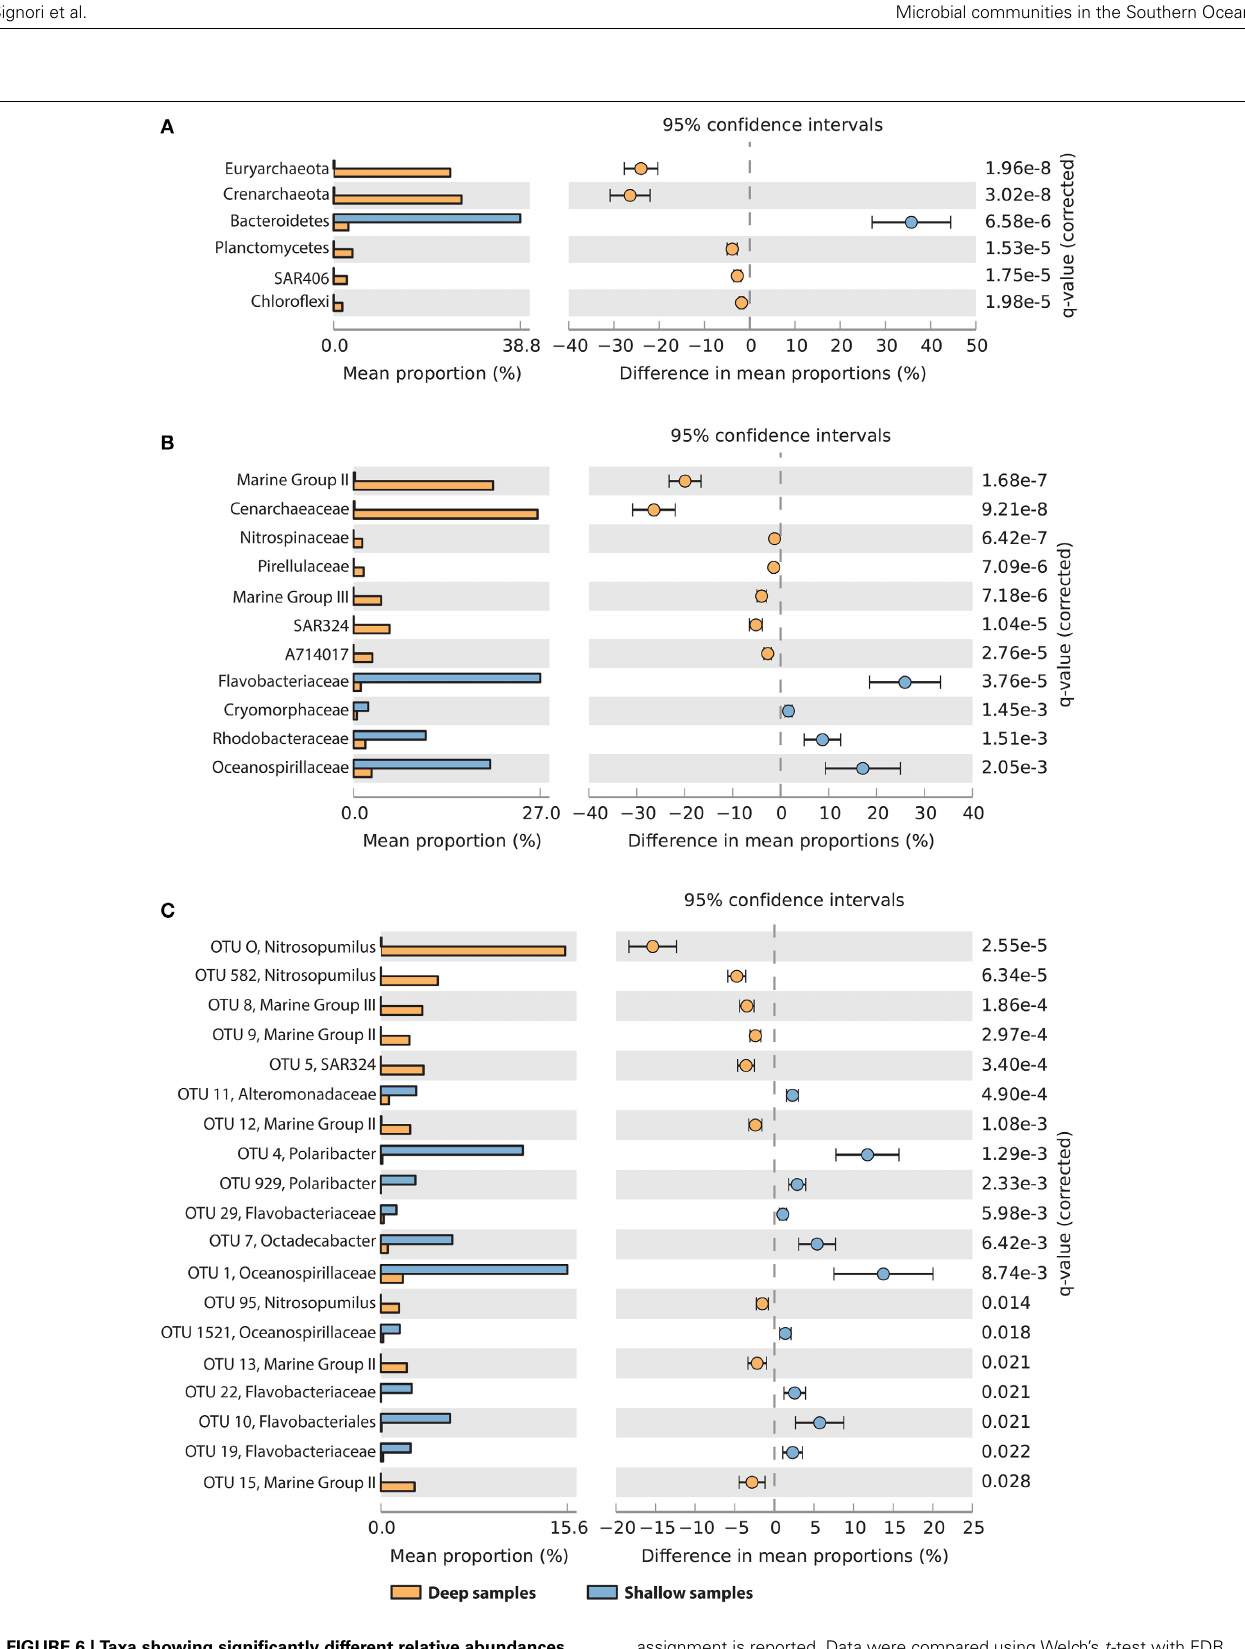
FIGURE 6 | Taxa showing significantly different relative abundances between “deep” samples (yellow, oxygen minimum, or seafloor) and “shallow” samples (blue, oxygen maximum or surface), at the phylum (A), family (B), and OTU (C) levels. For OTUs, the best taxonomic